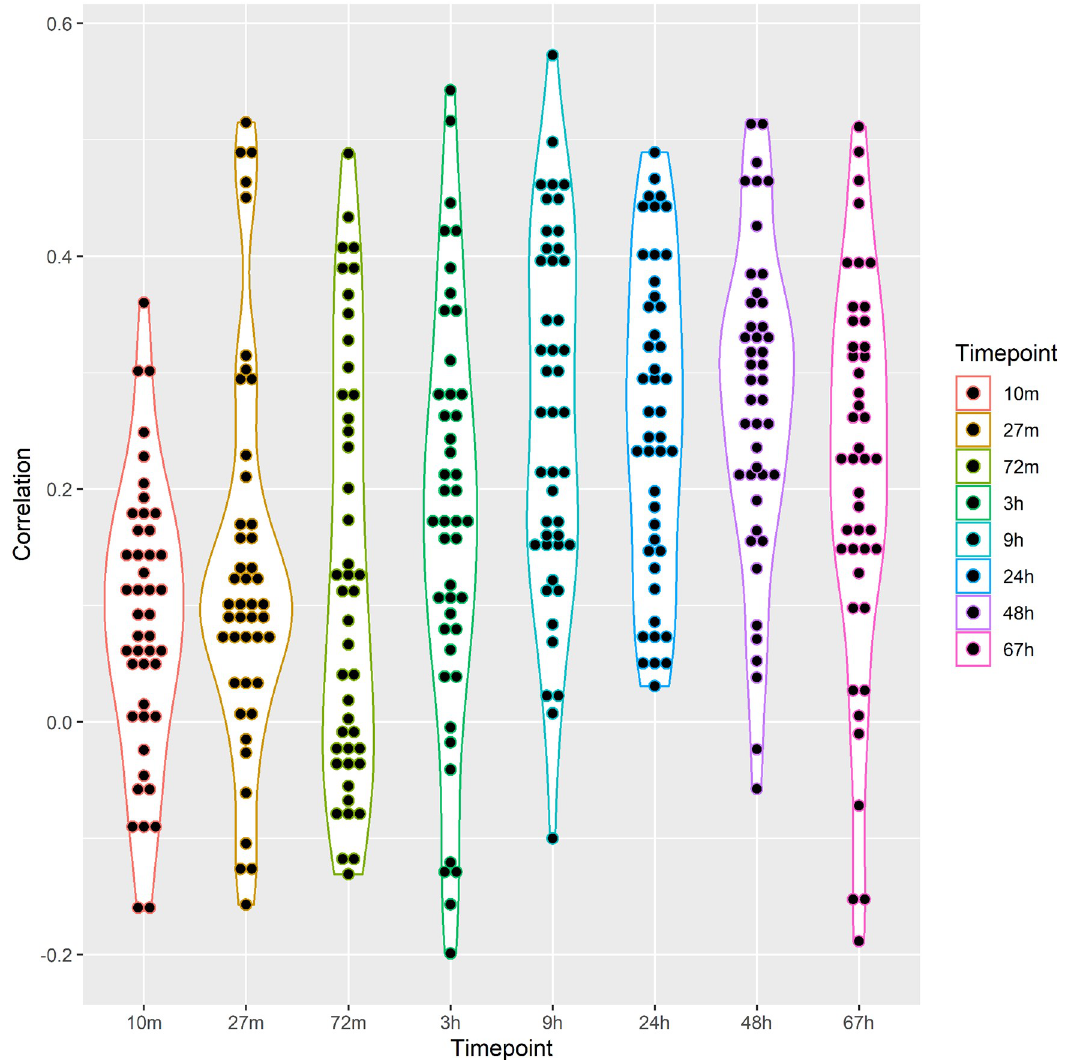
Fig 3. Comparison between PHENSIM predictions and the proteomics measurements of Nyman et al. [18]. We report the Pearson Correlation Coefficient computed between PHENSIM and the proteomics measurements for each timepoint and drug combination. Results are summarized through a violin plot detailing both the distribution and the values’